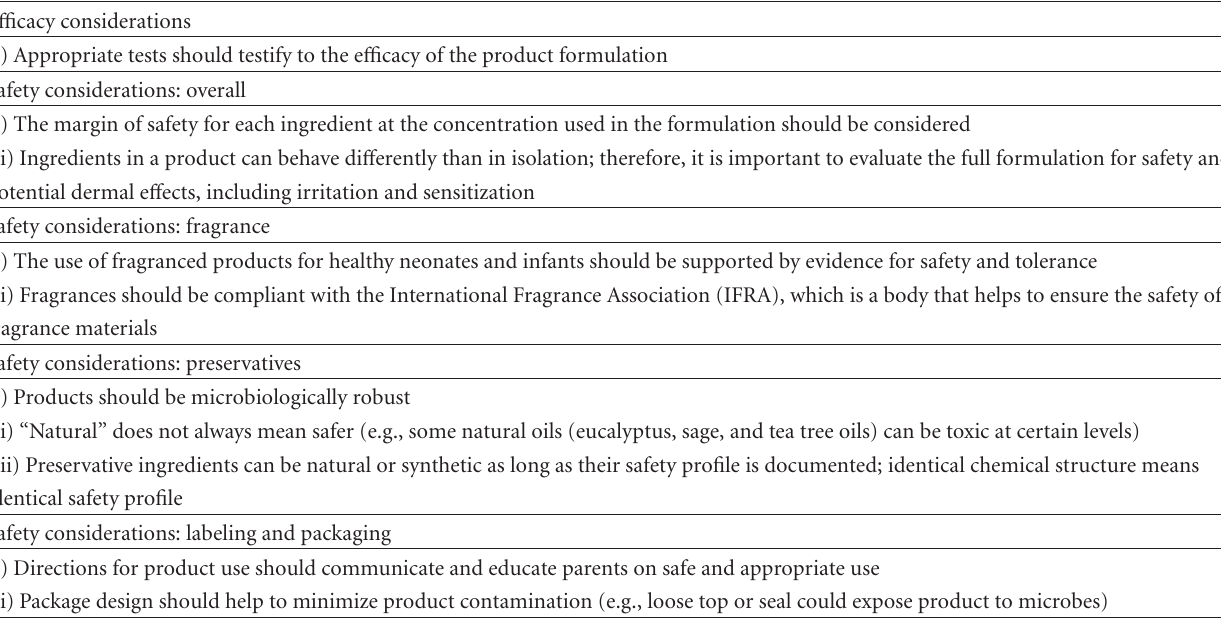
Table 4: Practical considerations for emollient product